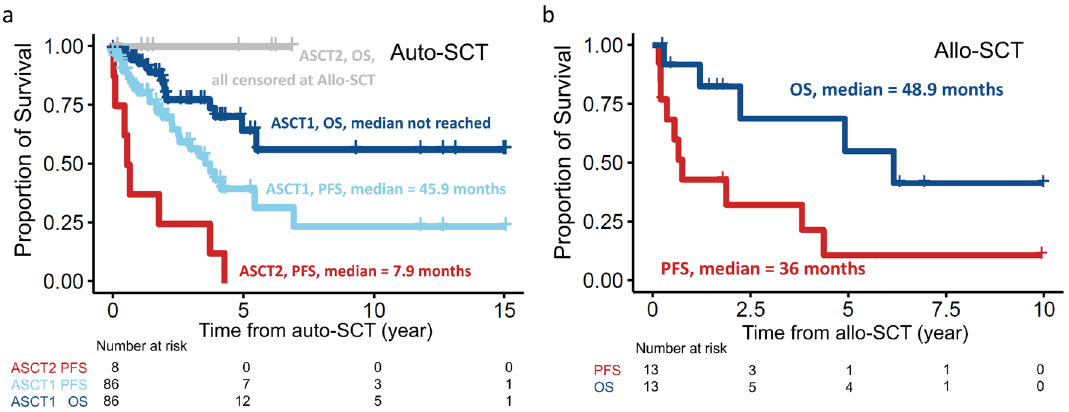
Figure 1. Kaplan–Meier plots of MCL patients receiving autologous (auto-) or allogeneic stem cell transplant (allo-SCT). ( a ) Progression-free survival (PFS) and overall survival (OS) of 86 patients receiving auto-SCT only (ASCT1) and 8 patients receiving auto-SCT and subsequent allo-SCT due to post-auto-SCT relapse (ASCT2). OS of ASCT2 patients were censored at the time of allo-SCT. ( b ) PFS and OS of 13 MCL patients receiving allo- SCT.